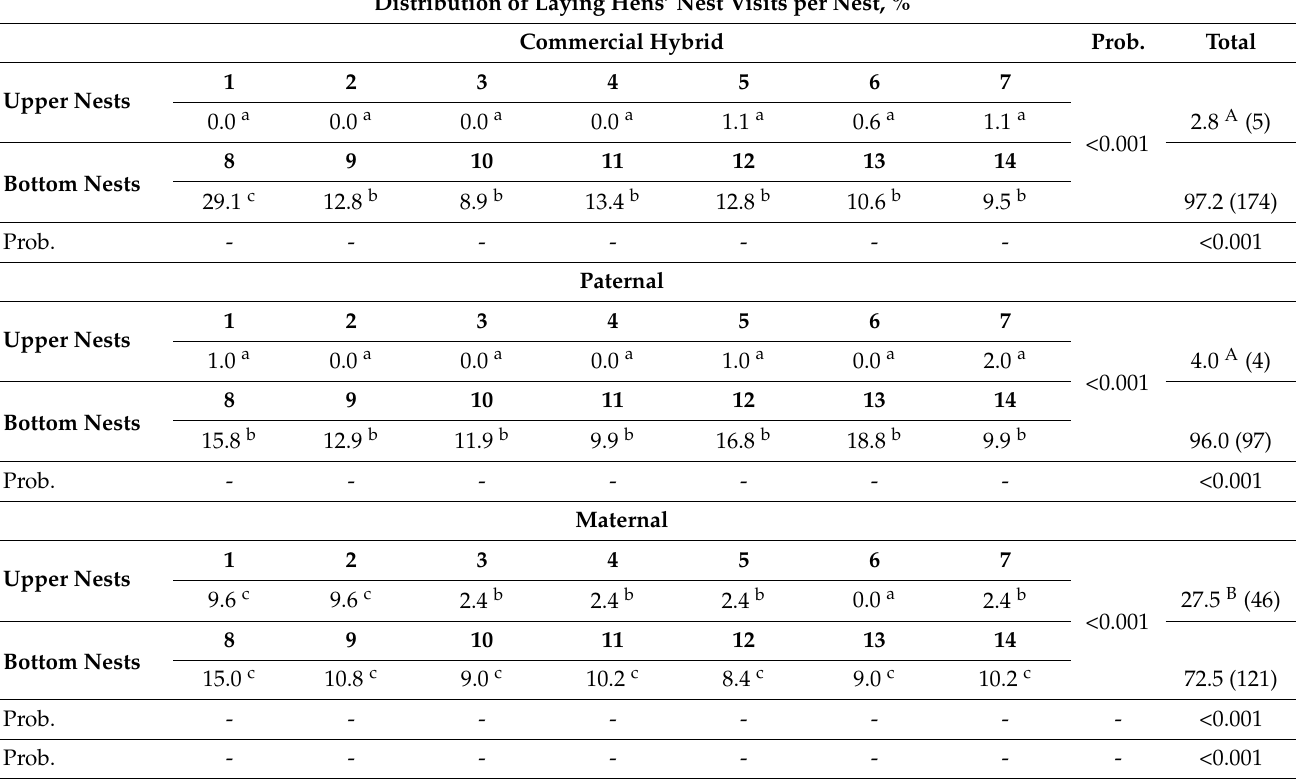
Table 3. The distribution of nest visit occasions of laying hens based on the position of the nests, in percentages (%). Distribution of Laying Hens’ Nest Visits per Nest, % Commercial Hybrid Prob.